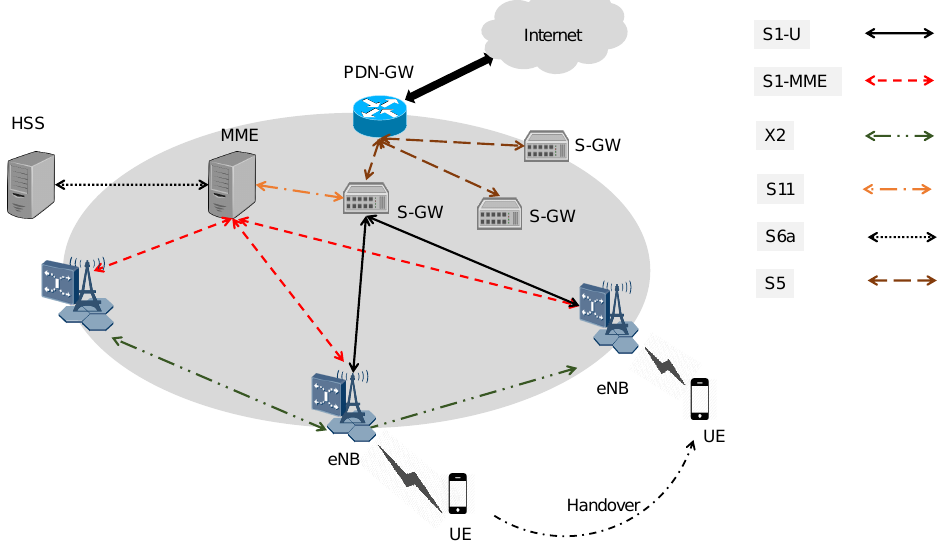
Figure 1. The Evolved Packet Core (EPC) model for 4th generation (4G) mobile